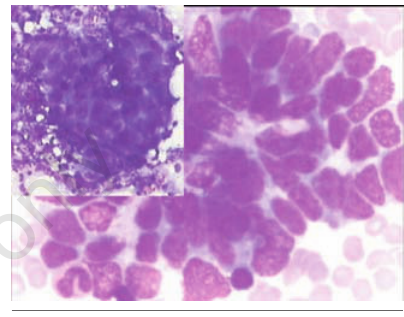
Figure 1. Bone marrow imprint smears showing metastatic solid tumor cells (x400, Jenner Giemsa; inset-x100, Jenner Giemsa).